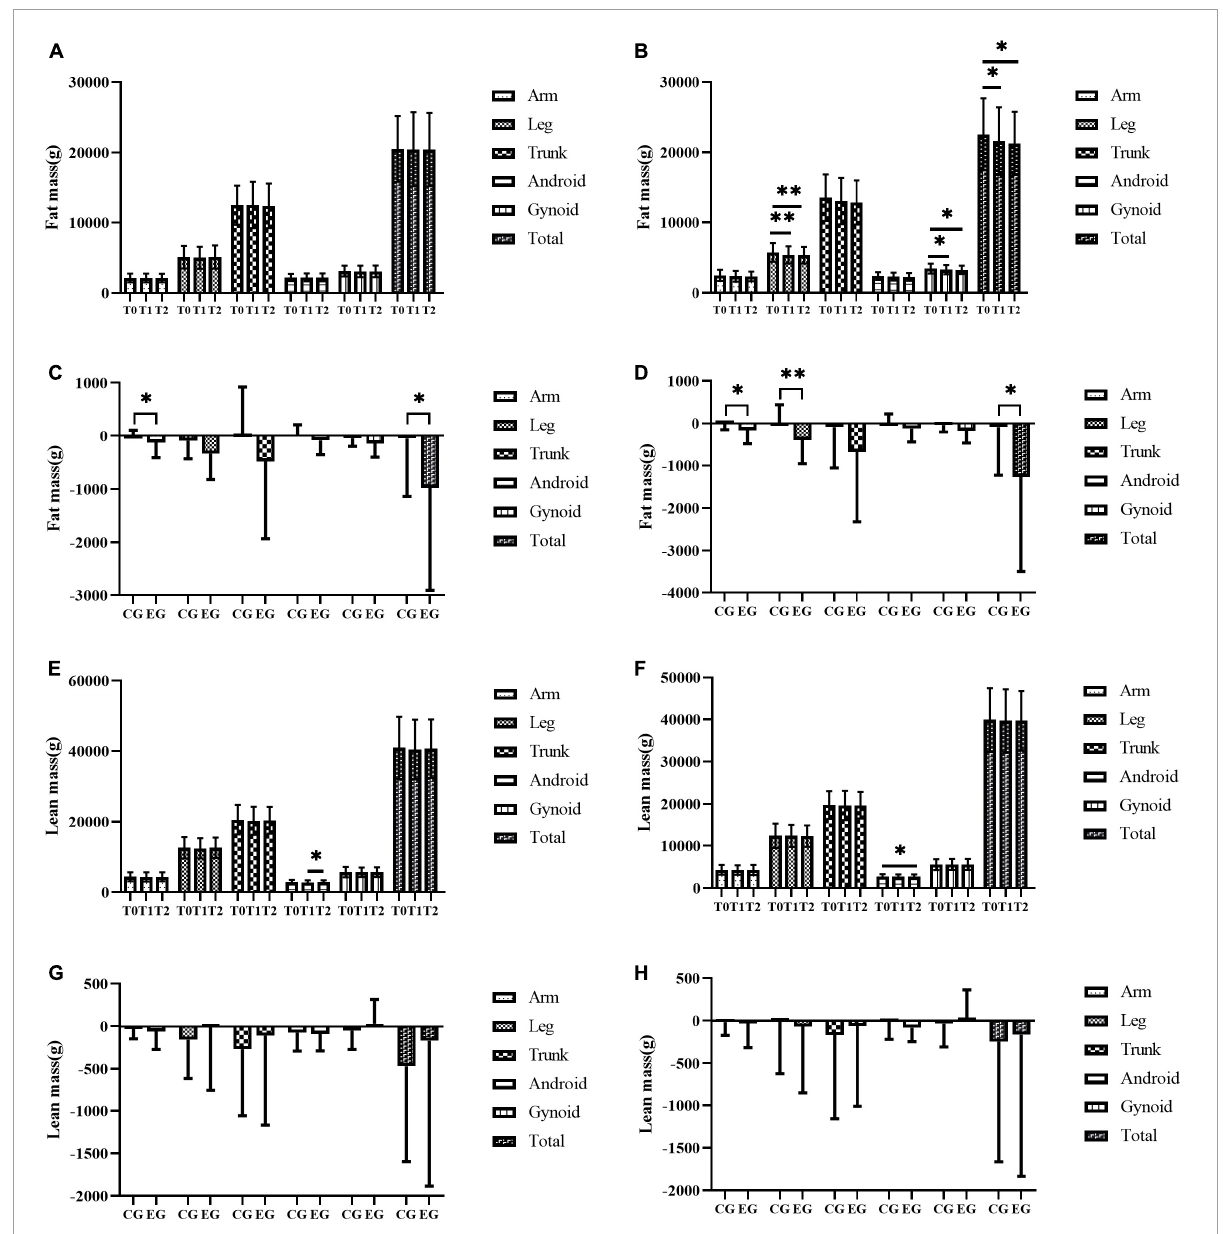
FIGURE2 The effect of exercise on fat content and lean mass in all parts of the body. (A–H) The fat mass of all parts of the body in the control group (A) , the fat mass of all parts of the body in the exercise group (B) , comparison of difference values between three months and baseline in different groups on fat mass in all parts of the body (C) , comparison of difference values between 6 months and baseline in different groups on fat mass in all parts of the body (D) , the lean mass of all parts of the body in the control group (E) , the lean mass of all parts of the body in the exercise group (F) , comparison of difference values between three months and baseline in different groups on lean mass in all parts of the body (G) , comparison of difference values between six months and baseline in different groups on lean mass in all parts of the body (H) . T0, T1, and T2 represent baseline, 3 months, and 6 months respectively. CG and EG represent control group and exercise group respectively. * represents p < 0.05 and ** represents p <